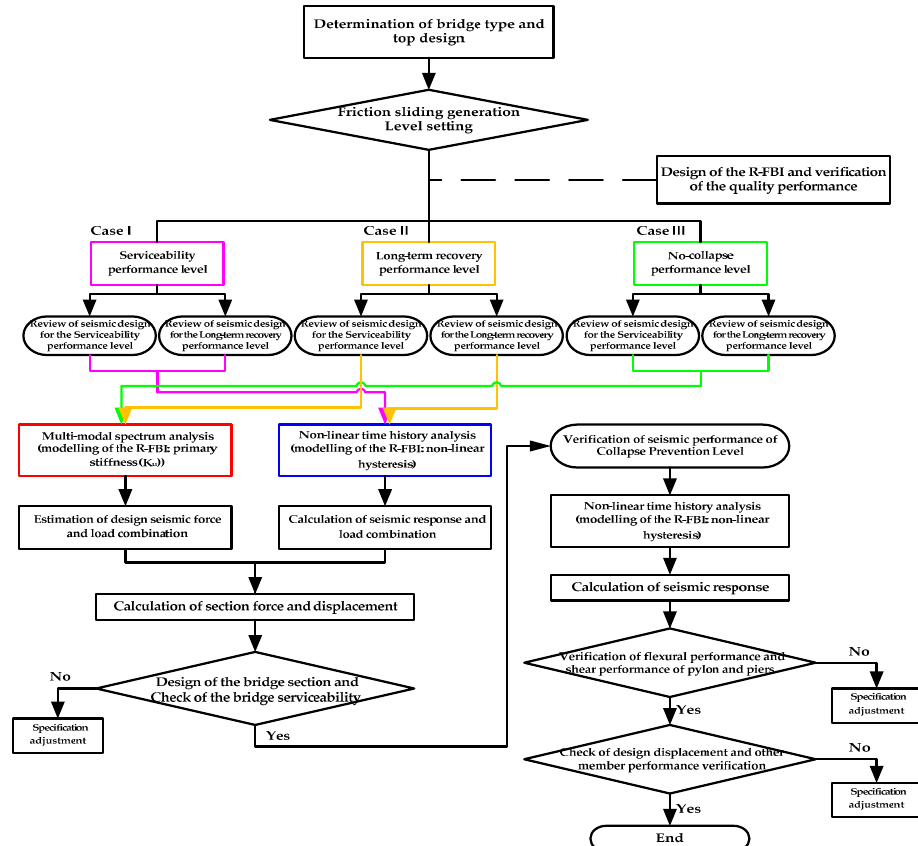
Figure 17. Proposed performance-based seismic design method for cable-supported bridges using resilient friction base isolation systems.